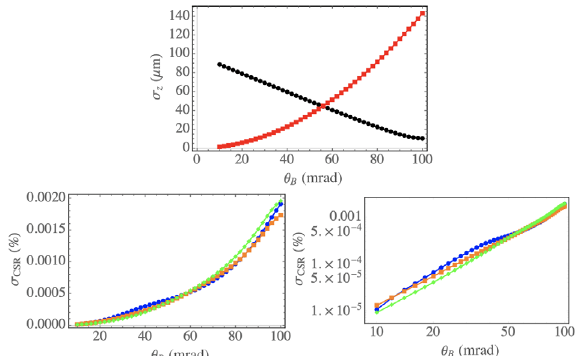
ELEGANT , but the scaling at moderate angles is inaccurate.